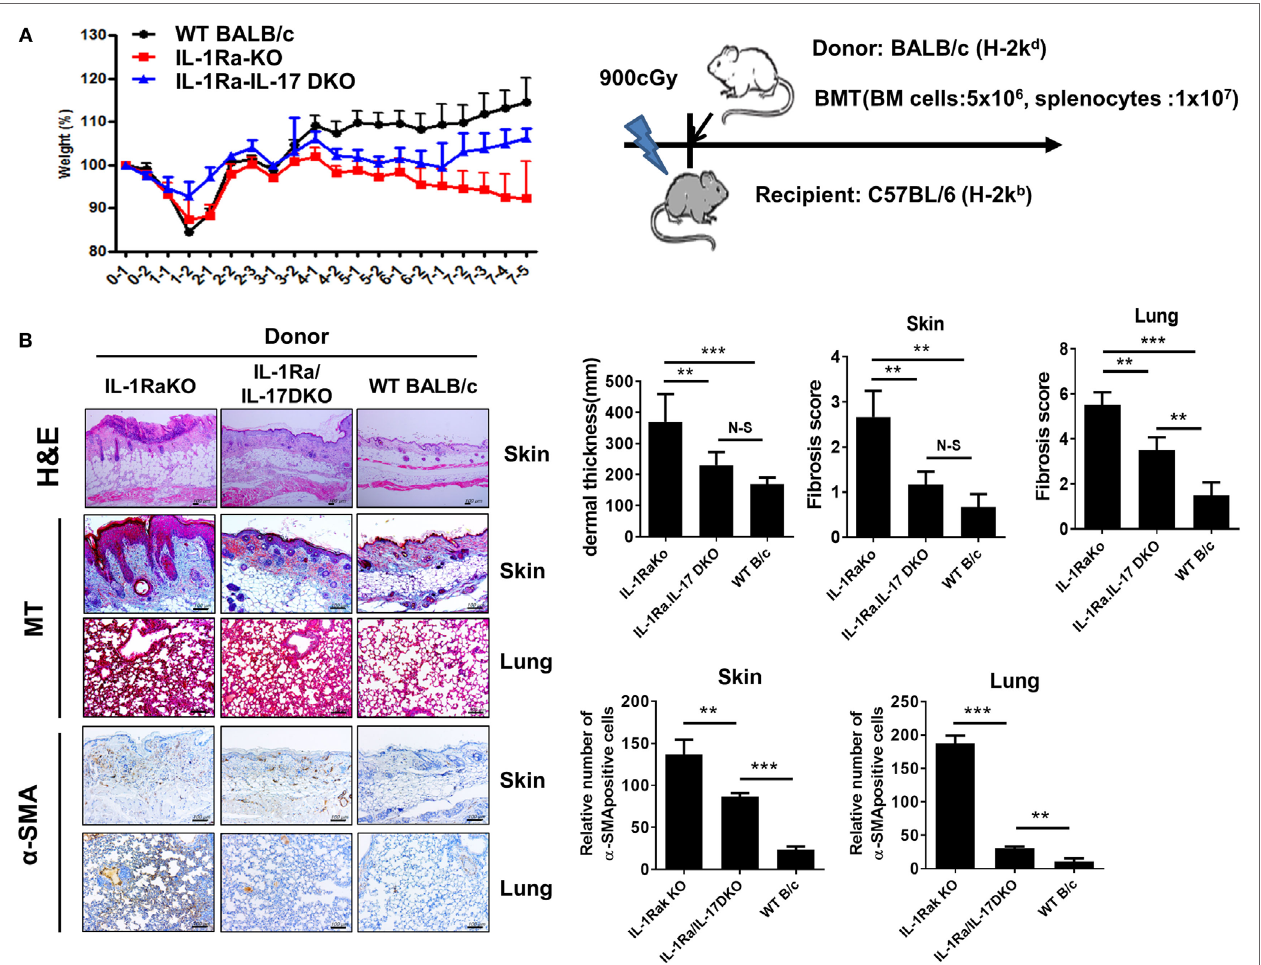
FigUre 6 | Antifibrotic effects of IL-17 blocking in sclerodermatous chronic graft-versus-host disease (cGVHD) models. (a) Weight was monitored in mice with cGVHD. Schematic representation of the murine sclerodermatous cGVHD model. Irradiated recipient C57BL/6 mice received 5 × 10 6 bone marrow (BM) cells and splenocytes (1 × 10 7 cells) from one of three different kinds of donor mice with a BALB/c background: wild-type (WT) BALB/c, IL-1 receptor antagonist-deficient (IL-1Ra-KO), and IL-1 receptor antagonist and IL-17 double-knockout (IL-1Ra–IL-17-double KO). (B) Left panel, representative sections stained with hematoxylin and eosin, and Masson’s trichrome (MT) and immunohistochemical staining for the frequency of α -SMA-positive cells in skin and lung tissues after BM transplantation (BMT; n = 10/group). Positive immunoreactivity appears as a brown color. The data are representative of two independent experiments. Tissues isolated at week 8 after BMT. Scale bar represents 100 µm. Right panel, dermal thickness, skin and lung fibrosis score, and the frequency of α -SMA-positive cells in skin and lung tissues are expressed as the mean ± SEM from two independent experiments ( n = 10 mice per group). ** p < 0.01, *** p <